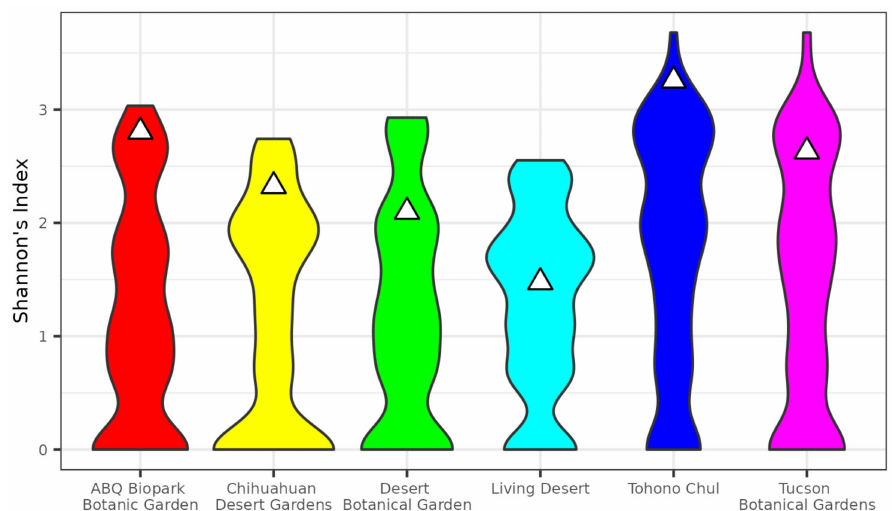
Figure 3. Comparison of species diversity in botanical gardens to samples of identical geographic size within city boundaries. Violins show distribution of Shannon’s index based on 1000 replicates and triangles show observed values of Shannon’s index for corresponding